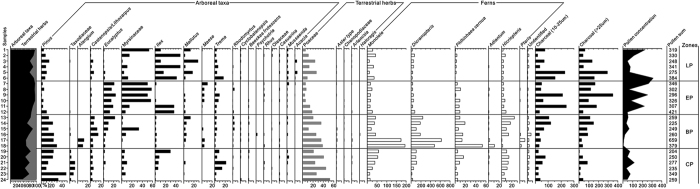
Surface soil pollen diagram in plantations in South China.Note: LP = legume plantation; EP = eucalyptus plantation; BP = broadleaved plantation; CP = coniferous plantation. The Y axis on the left indicates the sample number.